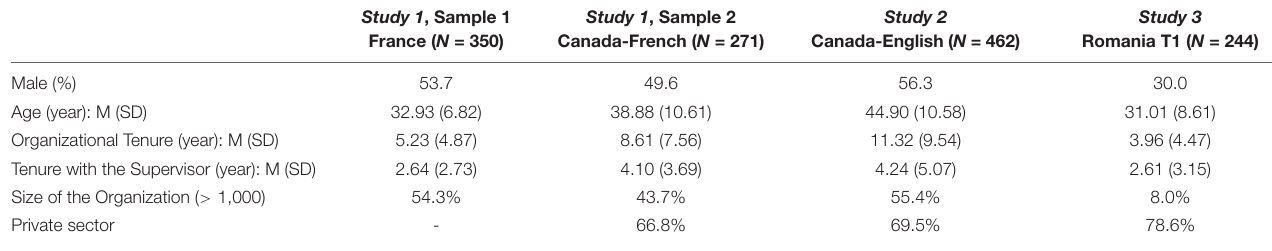
TABLE 1 | Demographics by